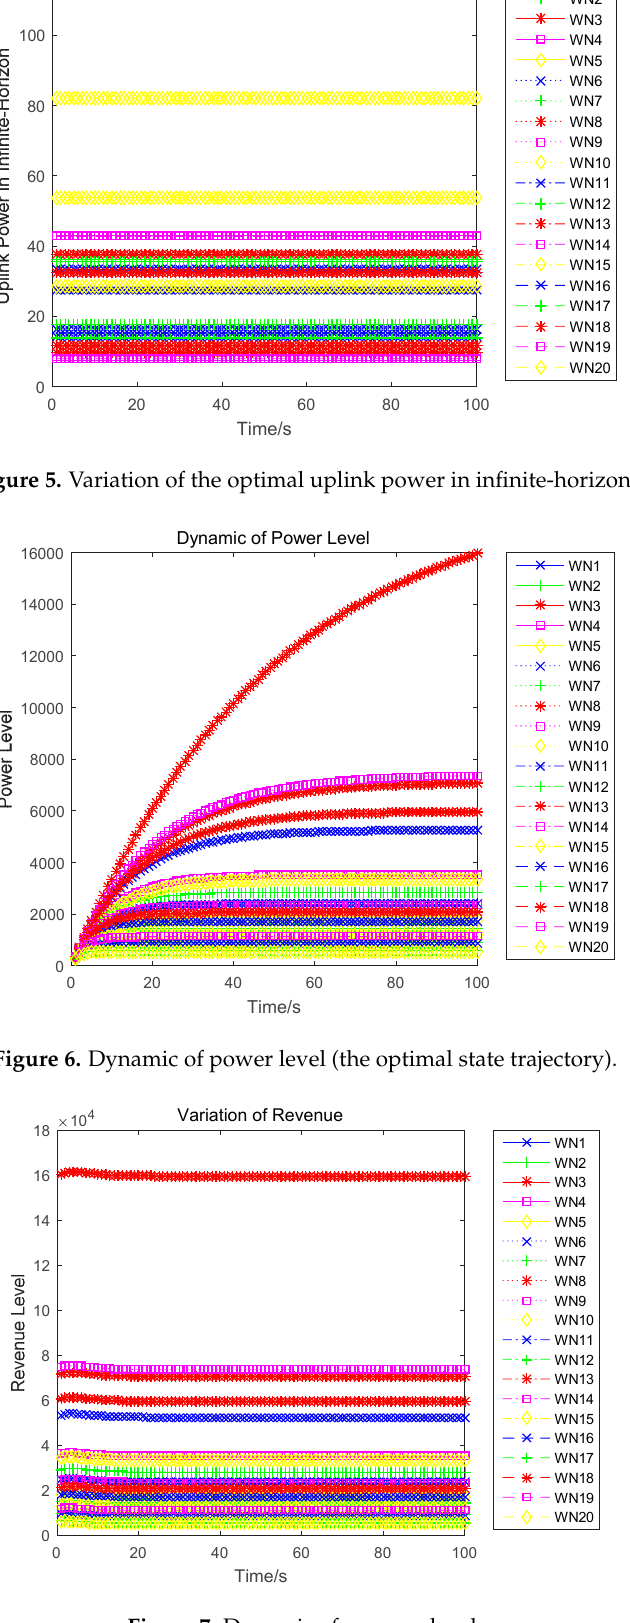
Figure 7. Dynamic of revenue level.